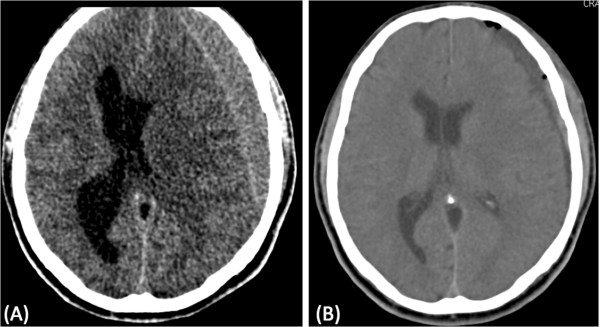
Computerized tomography scans (CT). (A) chronic subdural hematoma; (B) CT-scan 24 h after surgery.